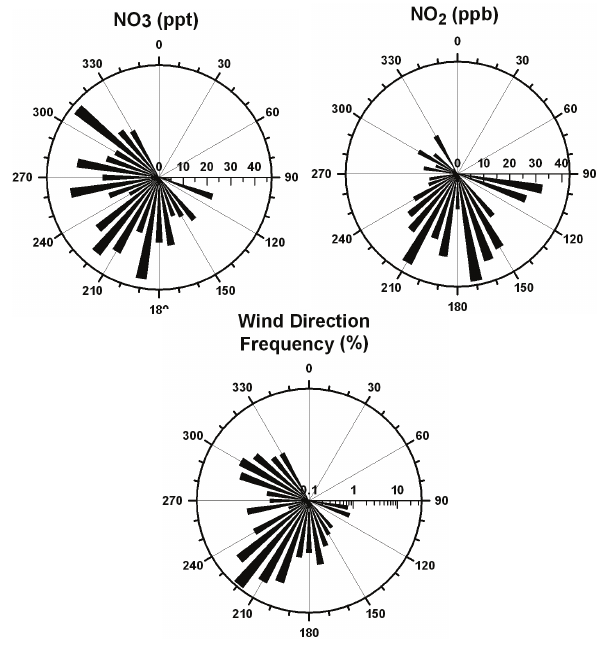
Fig. 6. Chemical and wind rose plots for (a) NO 3 mixing ratio (b) NO 2 mixing ratio and (c) frequency of winds, vs. wind direc- tion. For all three plots, only data with coincident wind speeds > 2kmh − 1 was included. For (a) and (b) radial direction repre- sents the 95th percentile of the group of observations in each 10 ◦ bin. Note the log scale for panel